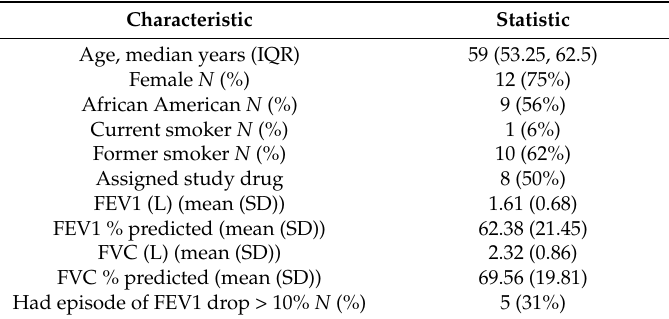
Table 1. Patient characteristics and